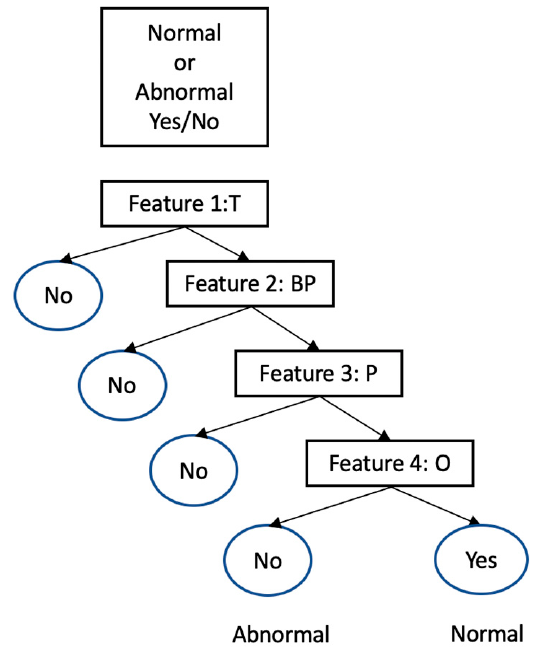
Figure 2. Decision tree for classifying the health condition into normal or abnormal based on the vital signs. The abbreviation T is for temperature, BP for blood pressure, P for pulses, and O for oxygen.